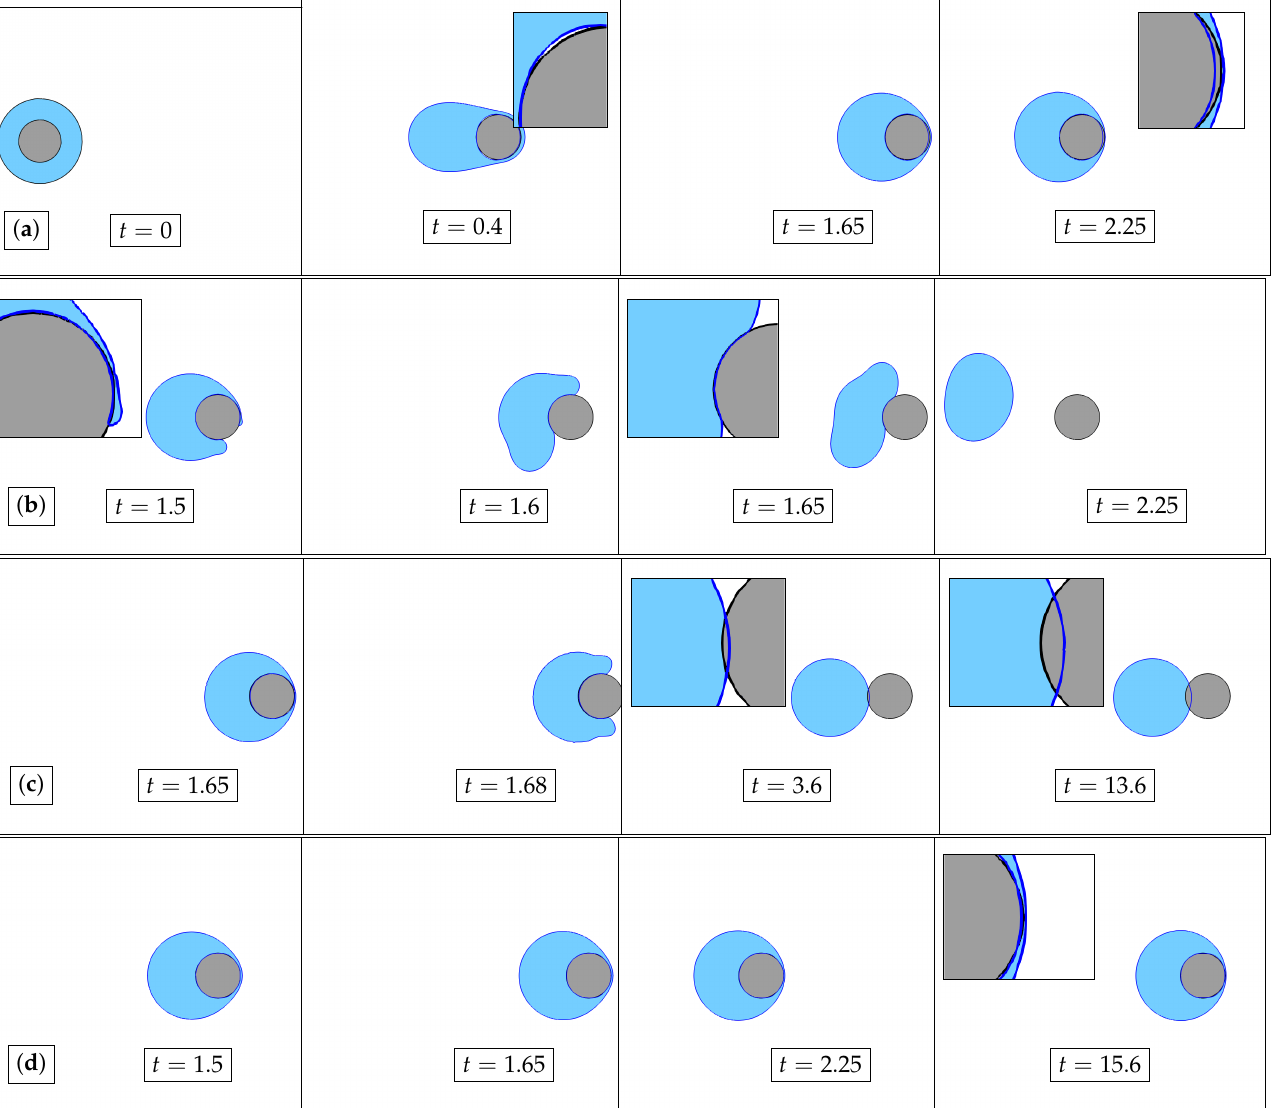
Figure 12. Motion of a solid cylinder (gray) covered by a fluid shell (blue) in a surrounding fluid (white). Left-right periodicity and top-bottom symmetry are assumed as boundary conditions. Simulations with different numerical methods: (a) – SSM without velocity correction; (b) – SSM with linear face velocity correction (29); (c) – BPM without velocity correction; and (d) – BPM with nonlinear correction (15). The results are shown at different times t . The insets highlight the relative location of the interfaces, where dark blue indicates the interface of fluid 1 and black indicates the solid boundary.